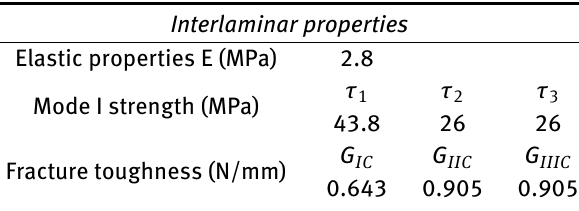
Table 6: Interlaminar properties of composite [34]